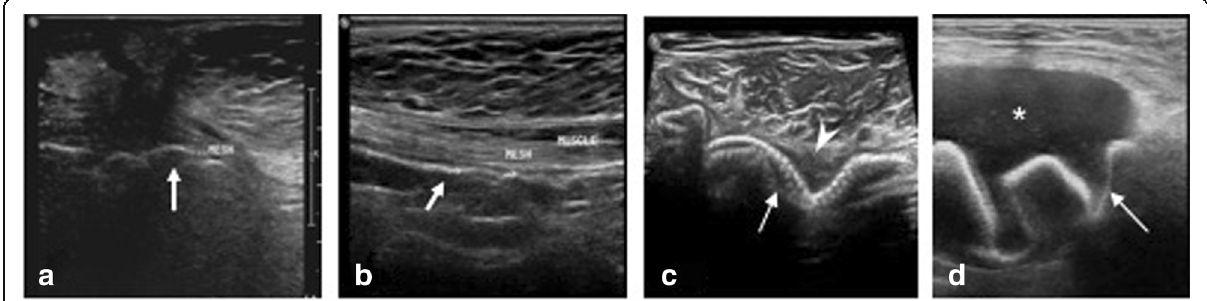
Fig. 4 Mesh appearances on USG using high-resolution linear probe. a Wavy echogenic appearance of mesh (arrow) in a post umbilical hernia repair. b Inlay placement of mesh appearing echogenic on USG (arrow). c Early postoperative USG shows wavy echogenic mesh (arrow) made prominent by surrounding thin seroma (arrowhead). d Mesh migration (arrow) into a collection (*) in a post inguinal hernia